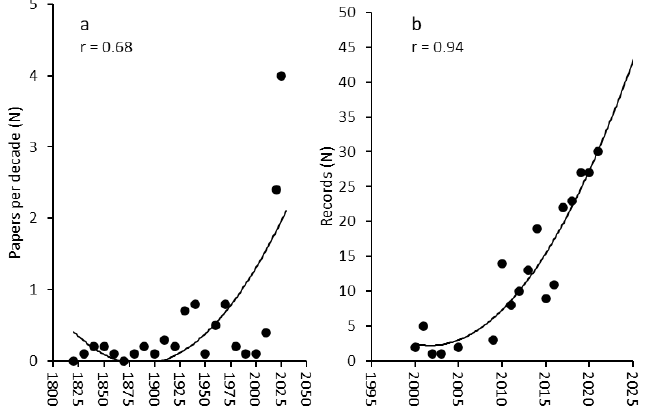
Figure 1. ( a ) Trends in the number of published scientific papers mentioning Astrospartus mediterraneus per decade from 1800 to the present and ( b ) of the number of records obtained from the citizen science databases divided per year from 2000 to the present.